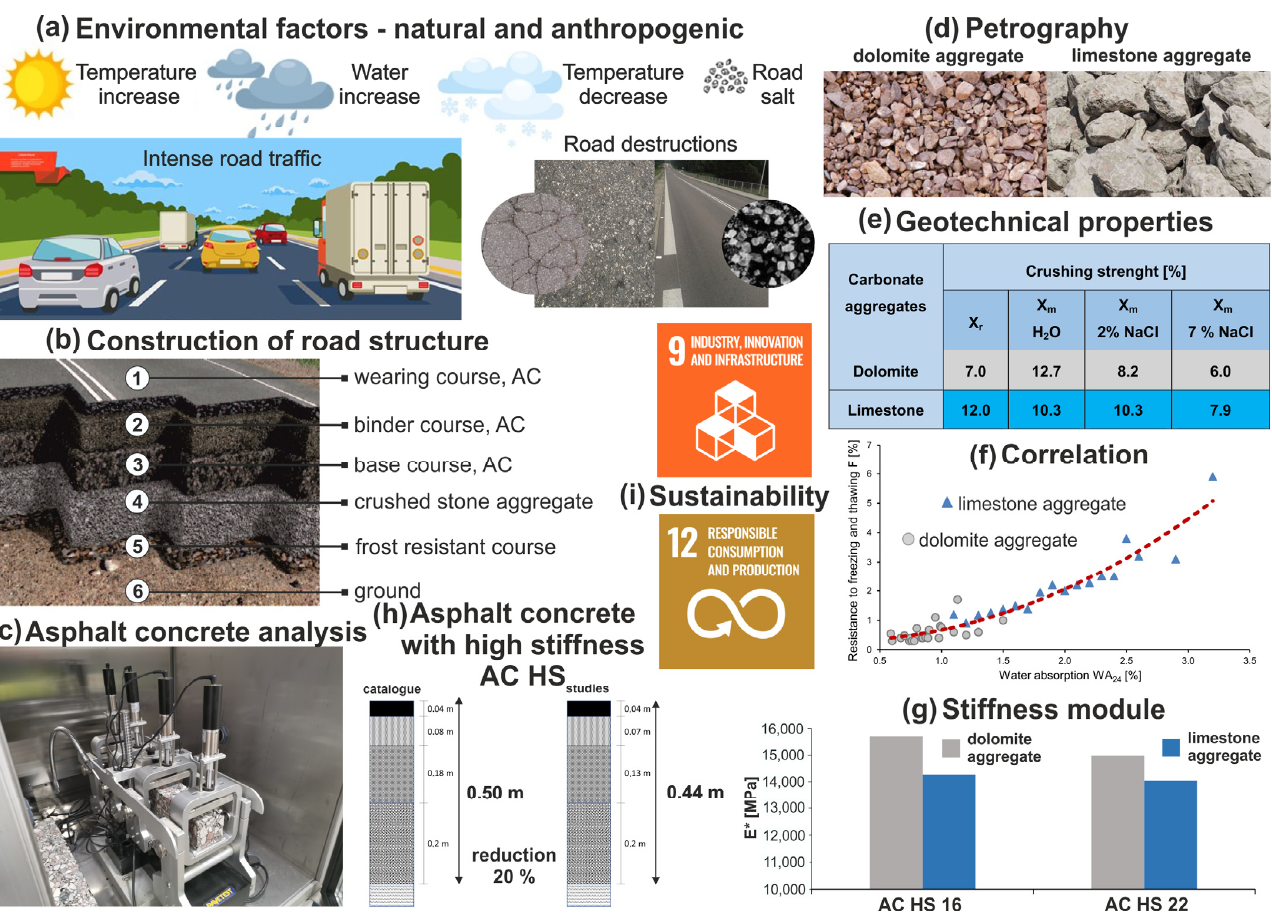
Figure 10. Summarized sustainability research on dolomite and limestone aggregates( a ) Environmental factors, ( b ) Con- struction of road structure, ( c ) Asphalt concrete analysis, ( d ) Petrography, ( e ) Geotechnical properties, ( f ) Correlation, ( g ) Stiffness module, ( h ) Asphalt concrete with high stiffness—AC HS, ( i ) Sustainability.